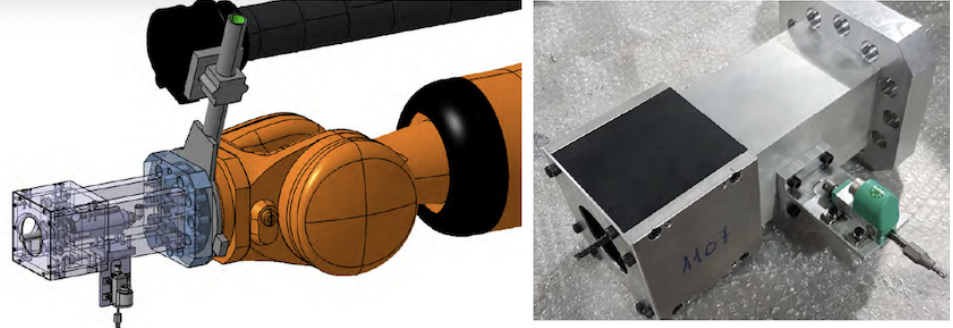
Figure 5. LEFT : Design of the end-effector for CFRP-skin removal. A rigid block connected to the robotic wrist holds a linear gauge and a spindle, located 90º from each other. RIGHT : Prototype of the